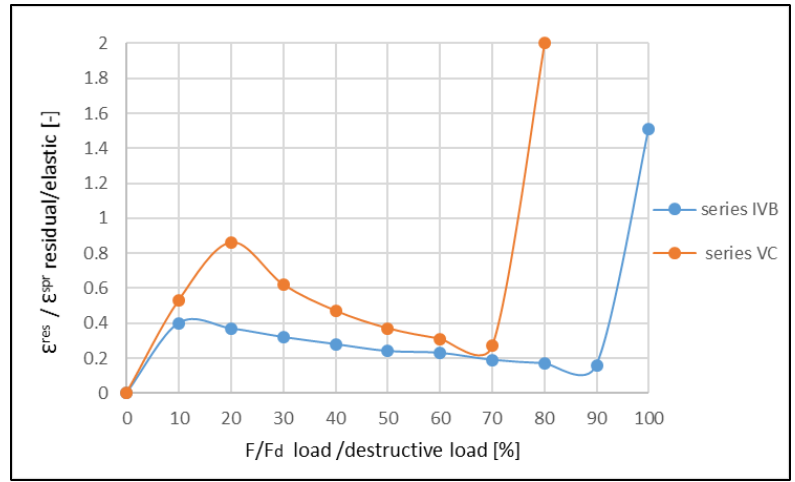
Figure 16. Comparison of the results, showing the ratio between residual and elastic strains for the beams of IV-th and V-th series.